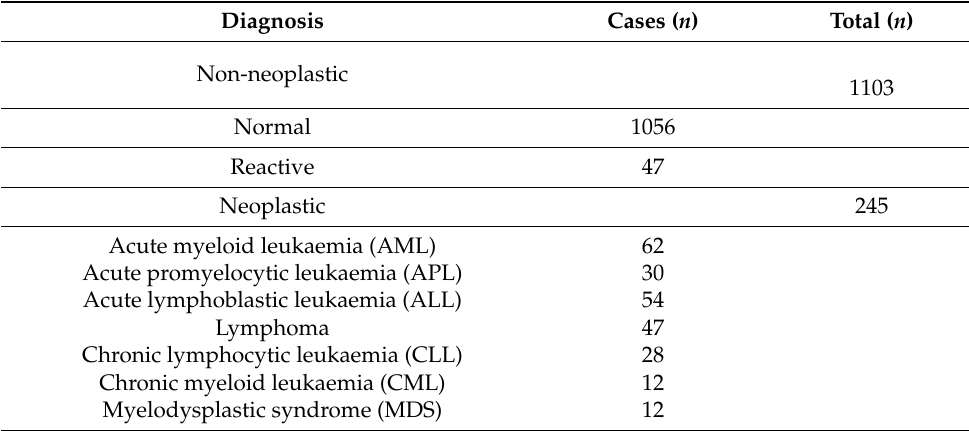
Table 1. Distribution of cases included in this